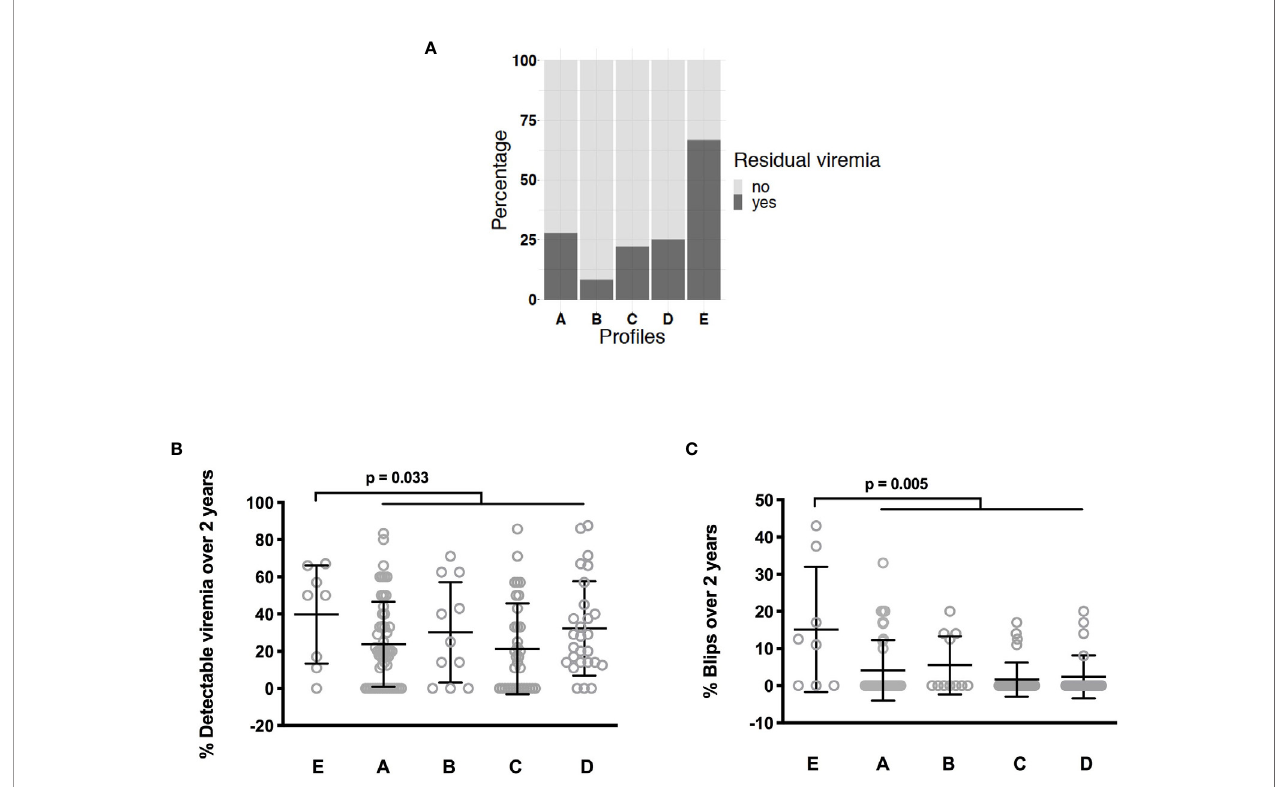
FIGURE 3 | Differences in the frequency of current low-level viremia between the various IA pro fi les. Statistical analyses were performed using a Kruskal-Wallis H test (A) . Differences in the frequency of low-level viremia (B) and blips (C) over the two last years between the various IA pro fi les. Statistical analyses were performed using a Mann-Whitney